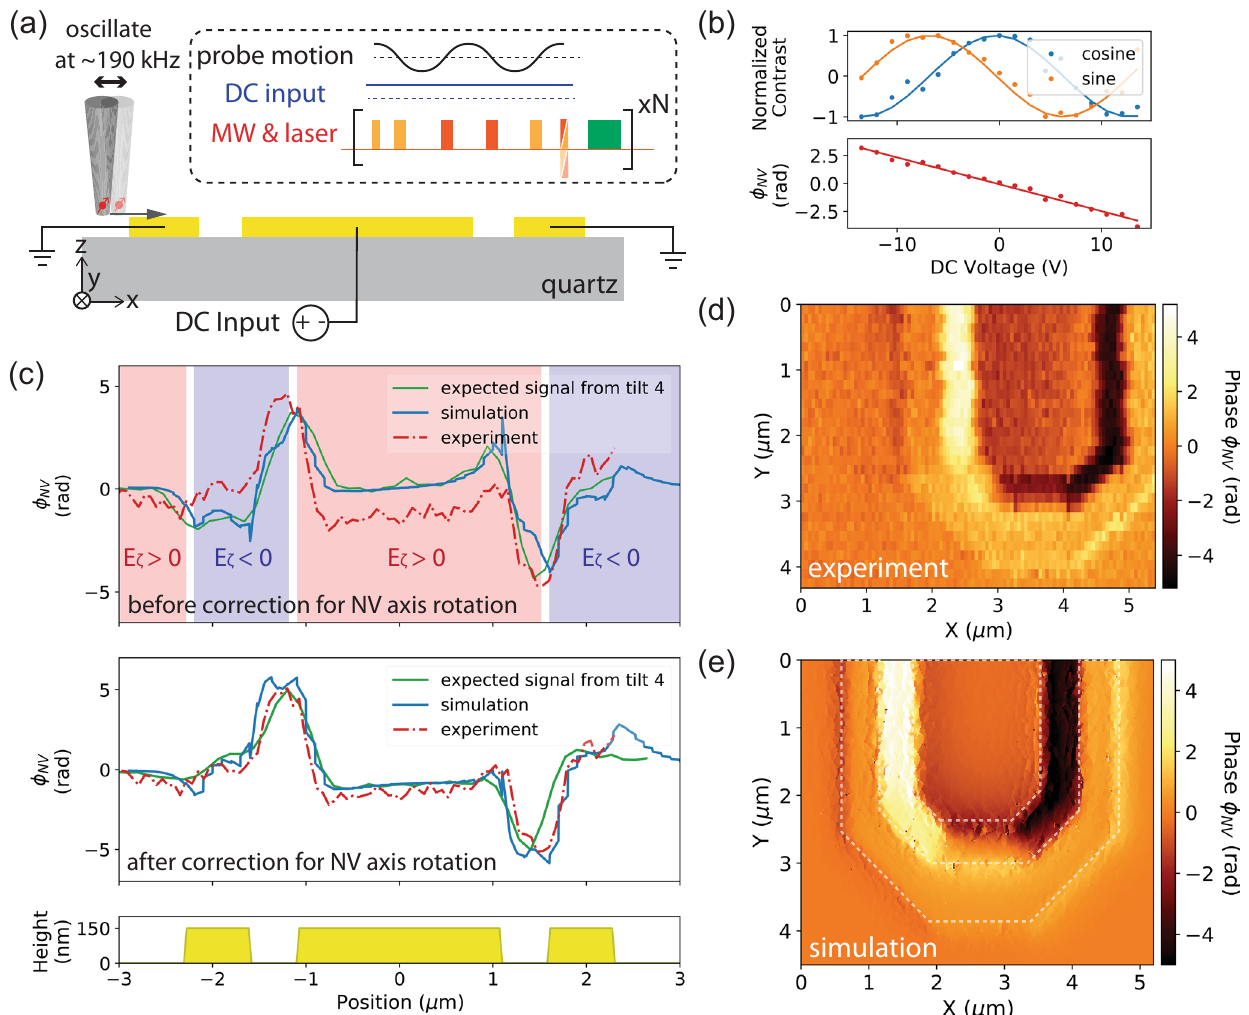
Fig. 4 DC electric fi eld imaging. a Schematic of scanning NV microscopy and the pulse sequence for DC electrometry. The input signal is DC, represented by a blue fl at line. The probe motion at ~190 kHz is synchronized with the XY-4 sensing pulse sequences. b NV measurements performed at a fi xed point within the gap. Top panel: the cosine and sine values measured by rotating the phase of the fi nal π /2 pulse. Bottom panel: Extracted phase ϕ NV proportional to the DC input amplitude. c 1D line scans of ϕ NV . The center electrode is at V dc = 16 V. Top panel: Discrepancy between the model ϕ NV ¼ d ? E 0 ζ ð x Þ A τ and data. The green trace shows the expected gradient fi eld signal calculated from tilt 4 in Fig. 3c. The blue trace shows the COMSOL simulation. The red (blue) background corresponds to the region of E ζ > 0 ( E ζ < 0) as shown in Fig. 3c. Middle panel: The model ϕ NV ¼ d ? ð E 0 ζ ð x Þ A þ β E ζ Þ τ showing an improved agreement with data, where A = 13 nm is the oscillation amplitude and β = − 0.03 is the proportionality constant that captures the NV axis rotation. Bottom panel: the height pro fi le of the metal. d 2D mapping of ϕ measured at V dc = 16 V. e Simulated signal ϕ NV at a distance of 140 nm from the sample. The maximum coupling axis 3e, and the oscillation amplitude is 13 nm. The white dashed lines outline the edge of the Au structure used in the